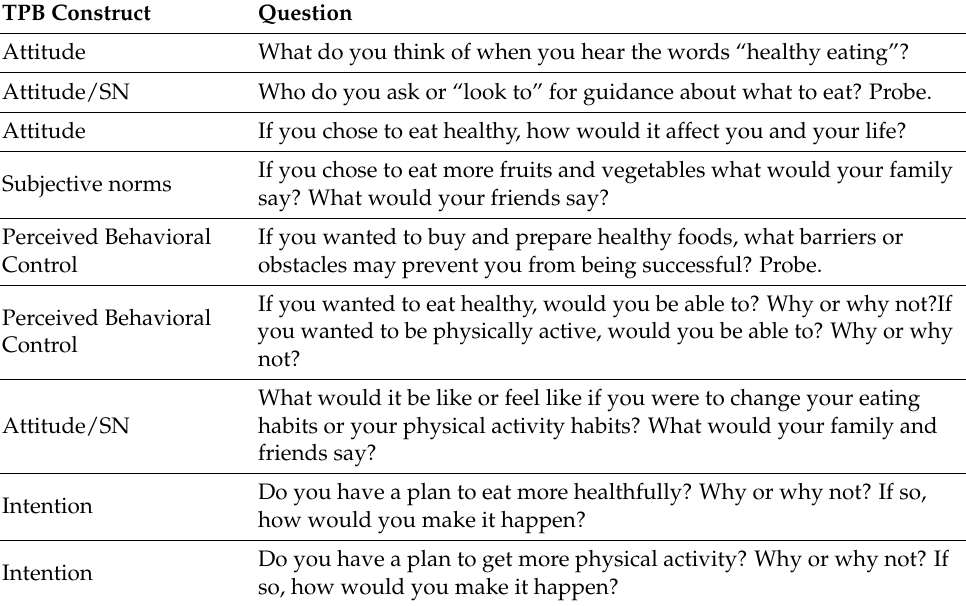
Table A1. Questions for focus group discussions in three low-income, rural